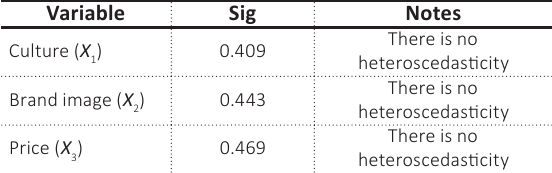
Table 3. Heteroscedasticity test result